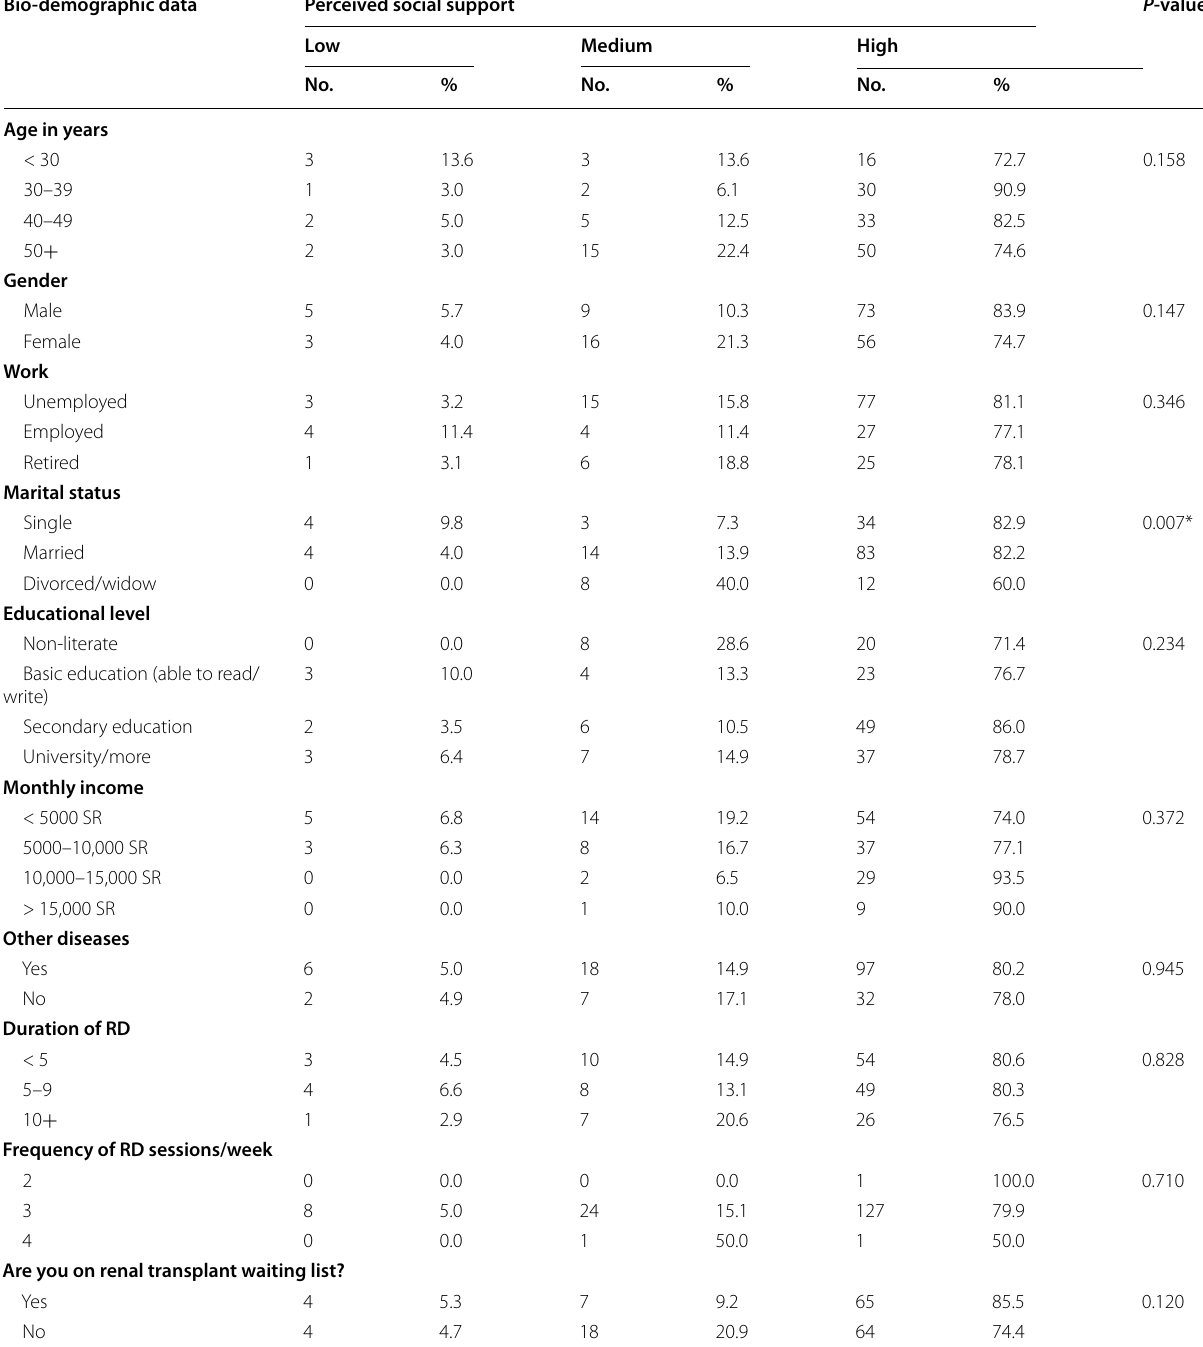
Table 4 Social support among haemodialysis patients by their bio-clinical data, Saudi